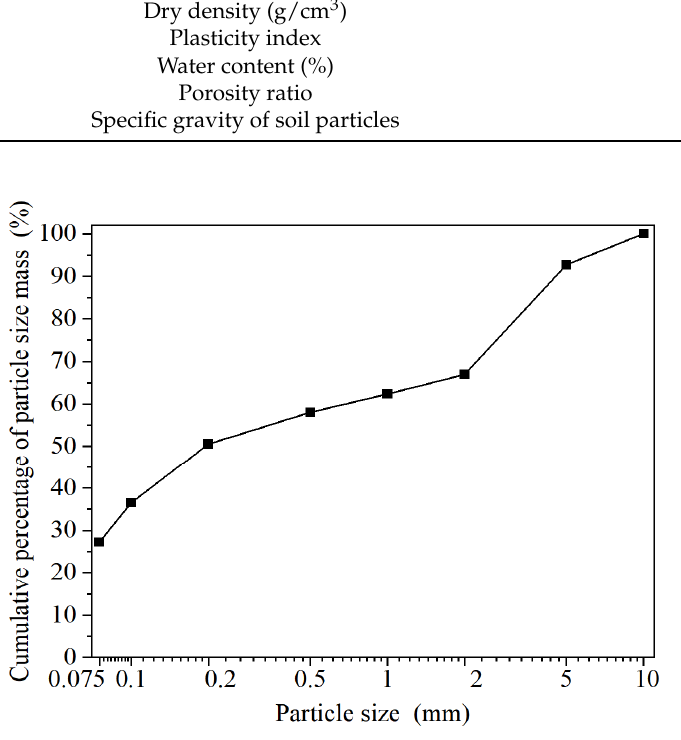
Figure 1. Cumulative curve of particle size mass